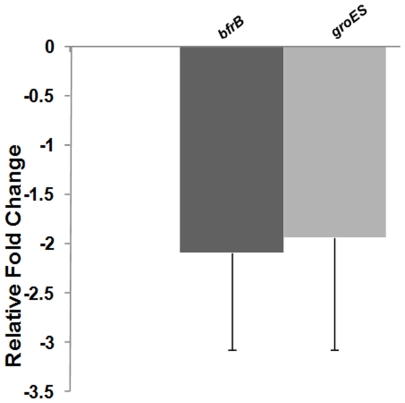
Relative fold change in the transcript levels of bfrB and groES genes.Real-time PCR was done using SYBR Green dye. Both genes were found to be significantly downregulated (∼2-fold) in Mtb/Hcl1cells when compared with the mycobacteria harbouring only pVV16. Experiment was performed using two biological replicates and in duplicates.